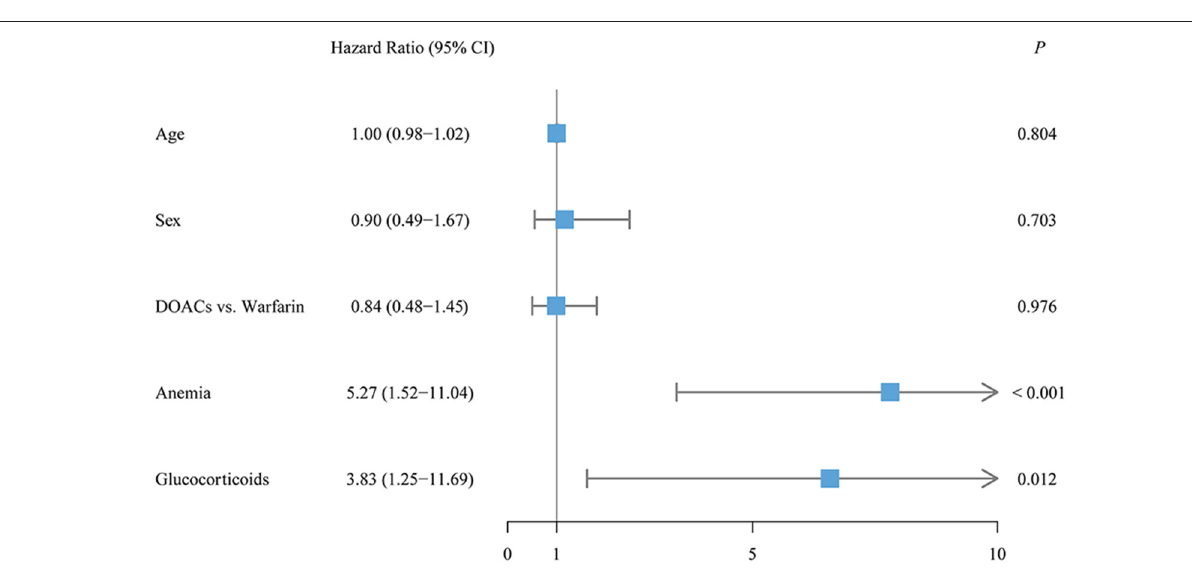
FIGURE 4 | The multivariate Cox regression analysis for clinically relevant